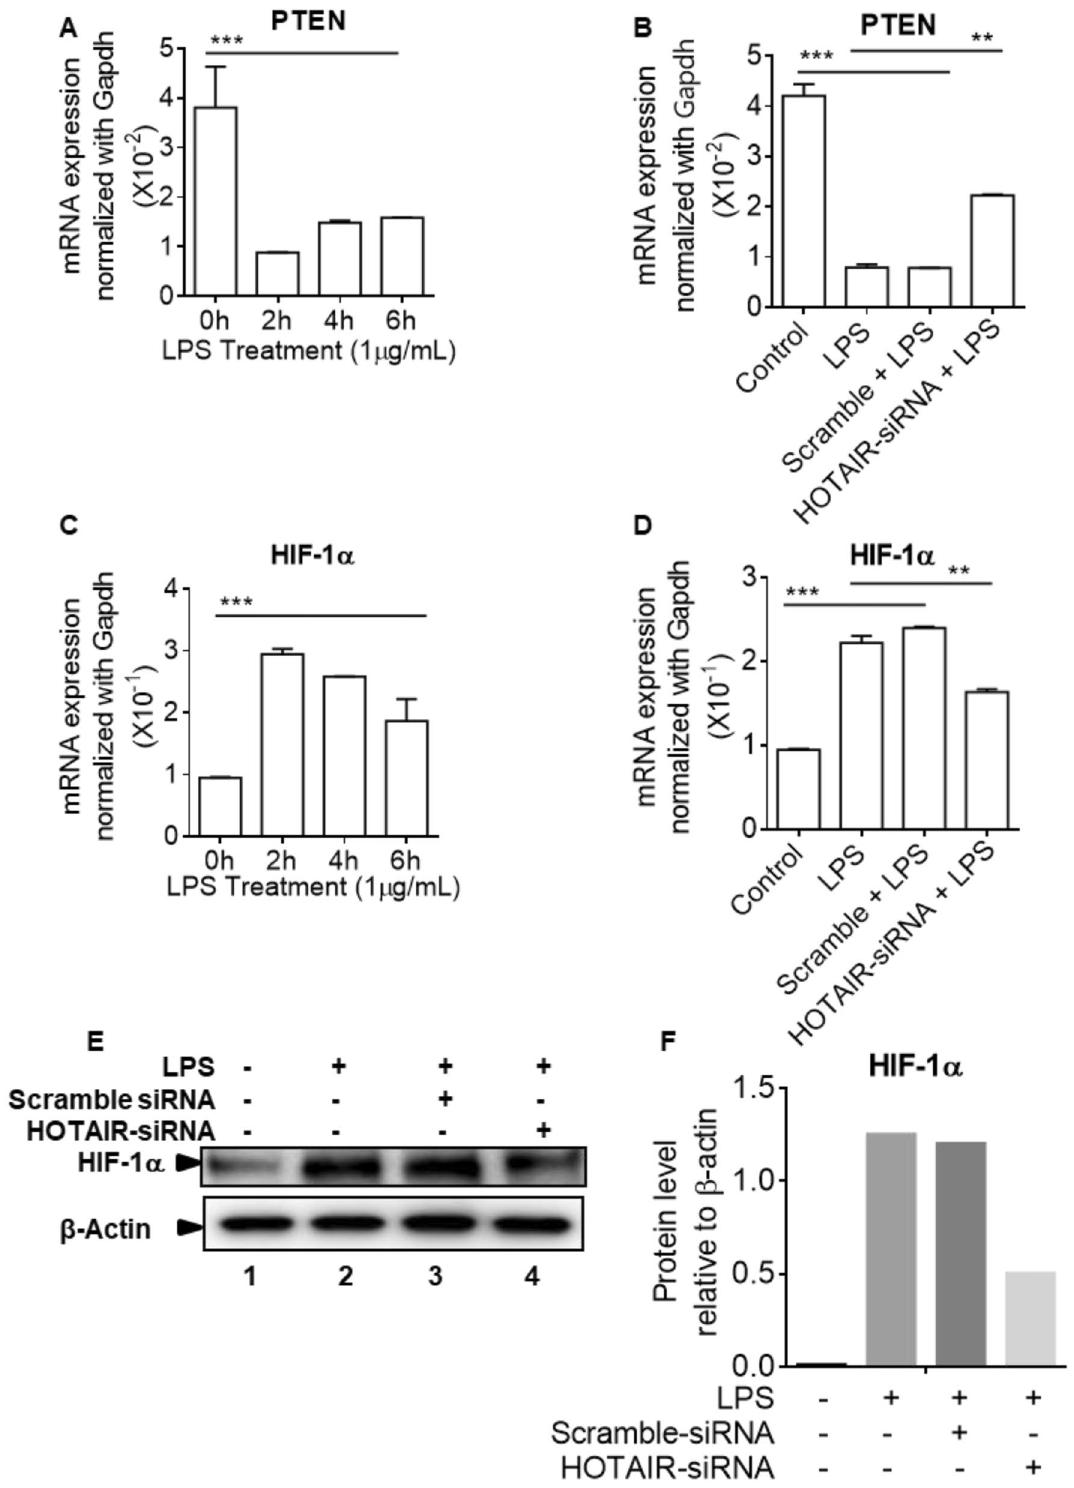
Figure 6. HOTAIR regulates upstream-regulators of glucose metabolism under LPS-simulation. ( A , C ): RAW264.7 cells were treated with LPS for varying times. RNA was analyzed by RT-qPCR for the expression of PTEN and HIF-1α. GAPDH was used as control. Data represent mean ± SD (n = 3); *p < 0.05, **p < 0.001, ***p < 0.0001. ( B , D ): RAW264.7 cells were transfected (48 h) with HOTAIR-siRNA and scramble siRNA followed by treatment with LPS. RNA was analyzed by RT-qPCR for the expression of PTEN (panel B ) and HIF-1α (Panel D ). GAPDH was used as control. Data represent mean ± SD (n = 3); *p < 0.05, **p < 0.001, ***p < 0.0001. ( E , F ) Proteins from HOTAIR-siRNA and scramble siRNA treatments (48 h) followed by 1 h LPS-treated RAW264.7 cells were analyzed by Western blotting using antibodies against HIF-1α and β-actin (loading control). The changes in amounts of HIF-1α have been quantified by ImageLab5.2.1 software and shown in panel F